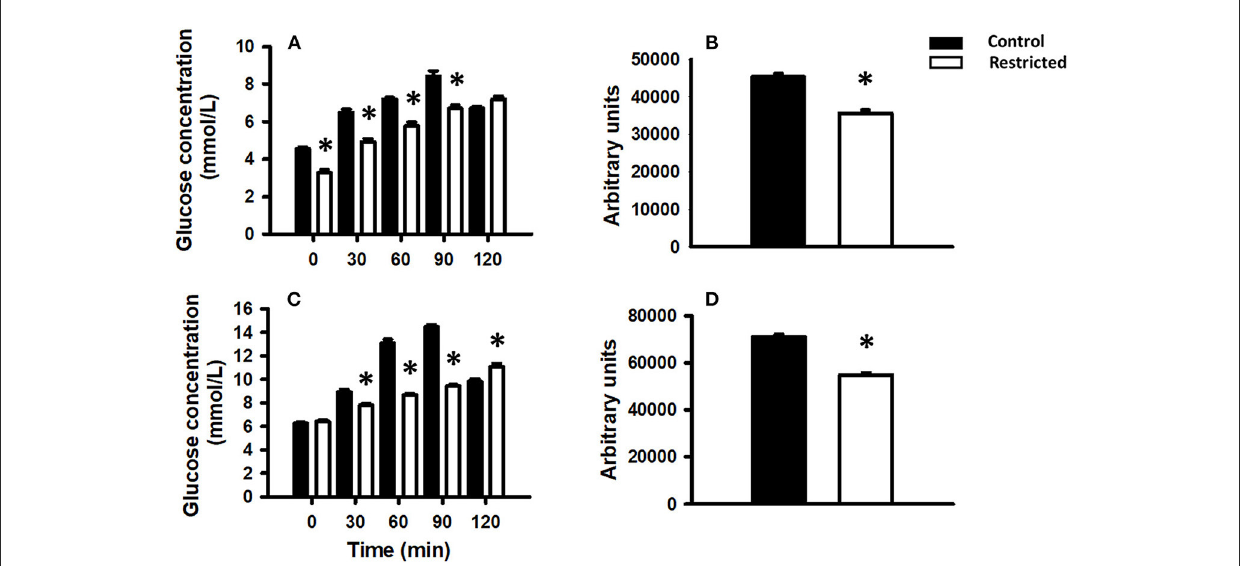
FIGURE3 Glucose tolerance in the offspring of mothers fed a control diet (filled bars) or a protein-restricted diet (empty bars). (A) Glucose tolerance in offspring at PND 36. (B) Corresponding area under the curve. (C) Glucose tolerance in offspring at PND 90. (D) Corresponding area under the curve. Data are expressed as the mean ± SEM from 8 to 10 rats/group. * P < 0.05 compared restricted (R) vs. control (C).